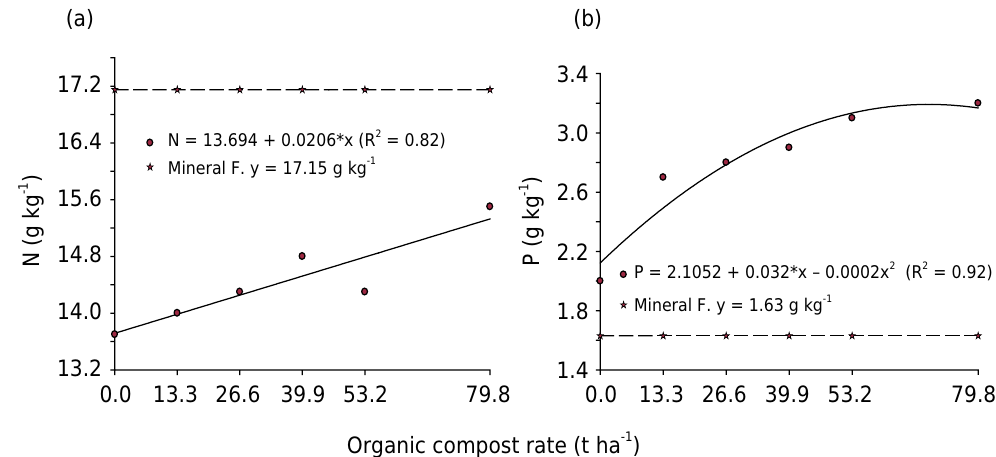
Organic compost rate (t ha -1 Figure 2. Content of nitrogen (a) and phosphorus (b) in the elephant grass sample leaf in response to organic compost rates and mineral fertilization. **: significant at 1 % probability.